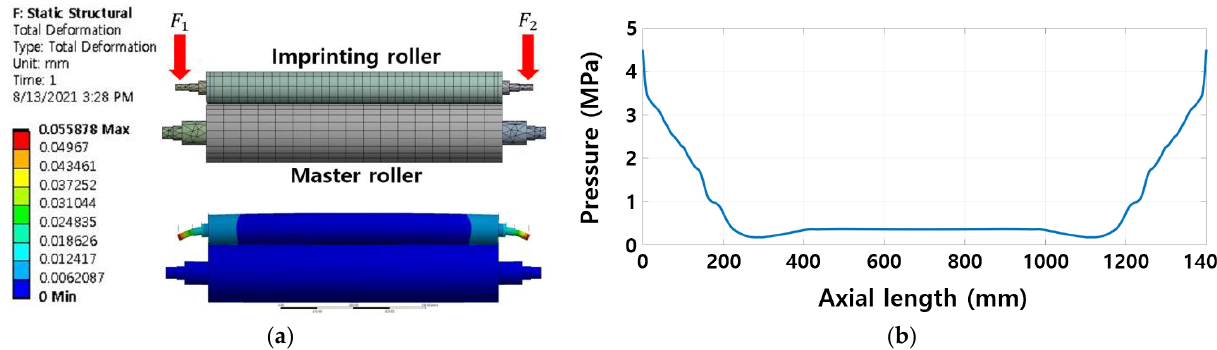
Figure 3. Pressure distribution along roller during simulation (FEM): ( a ) Imprinting module of conventional R2R NIL used in simulation (FEM); ( b ) Distributed pressure on the contact area.